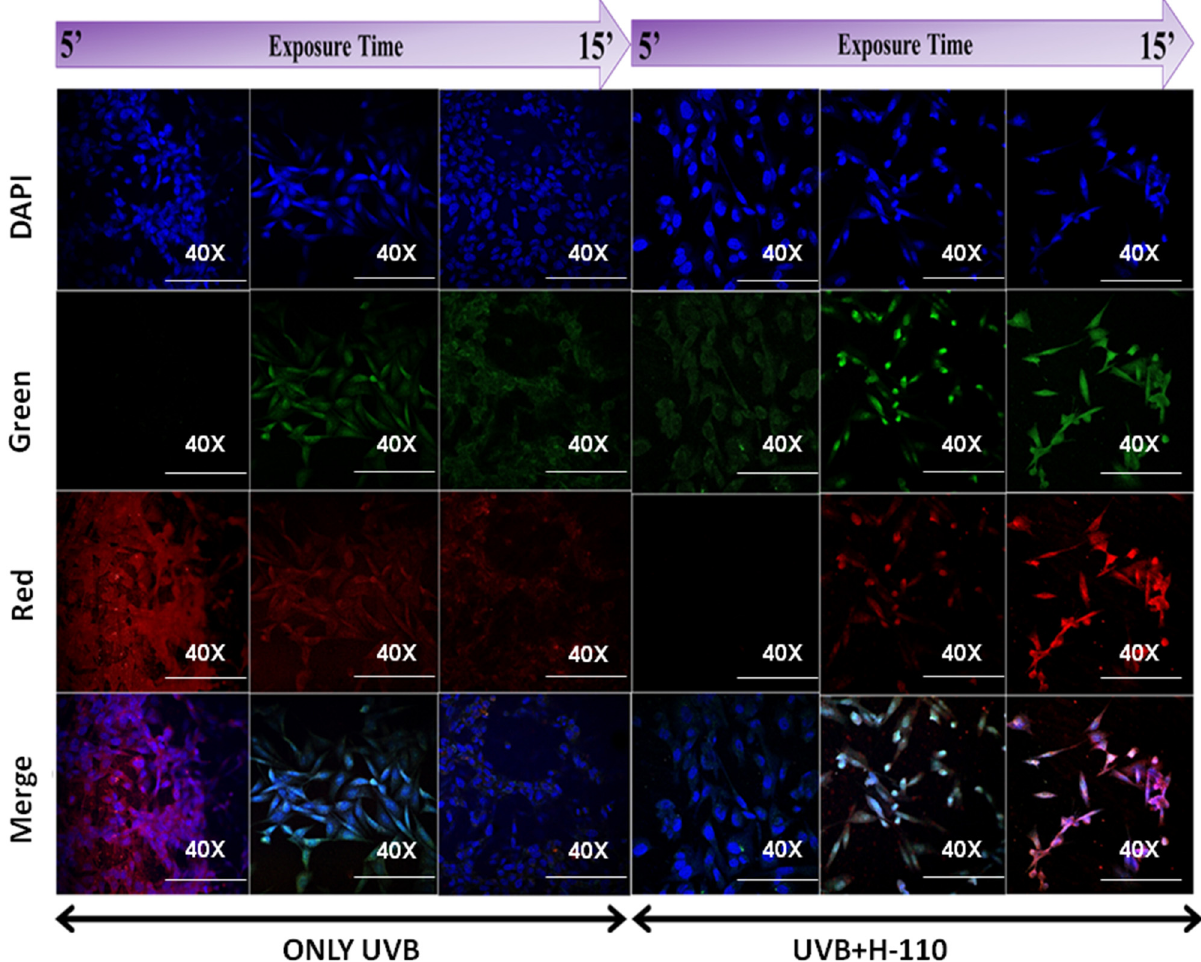
Figure 9: Protective role of H - 110 from UVB - induced cytological damage primary skin cell culture by confocal bioimaging, time - dependent experimental settings ( 5 – 15 min )